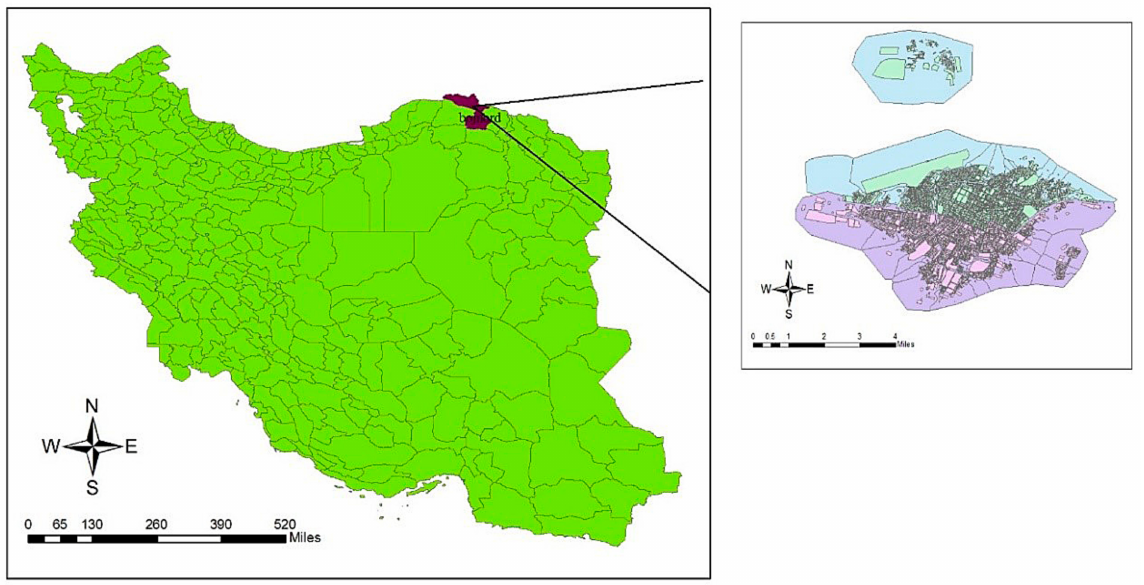
Figure 1. The study